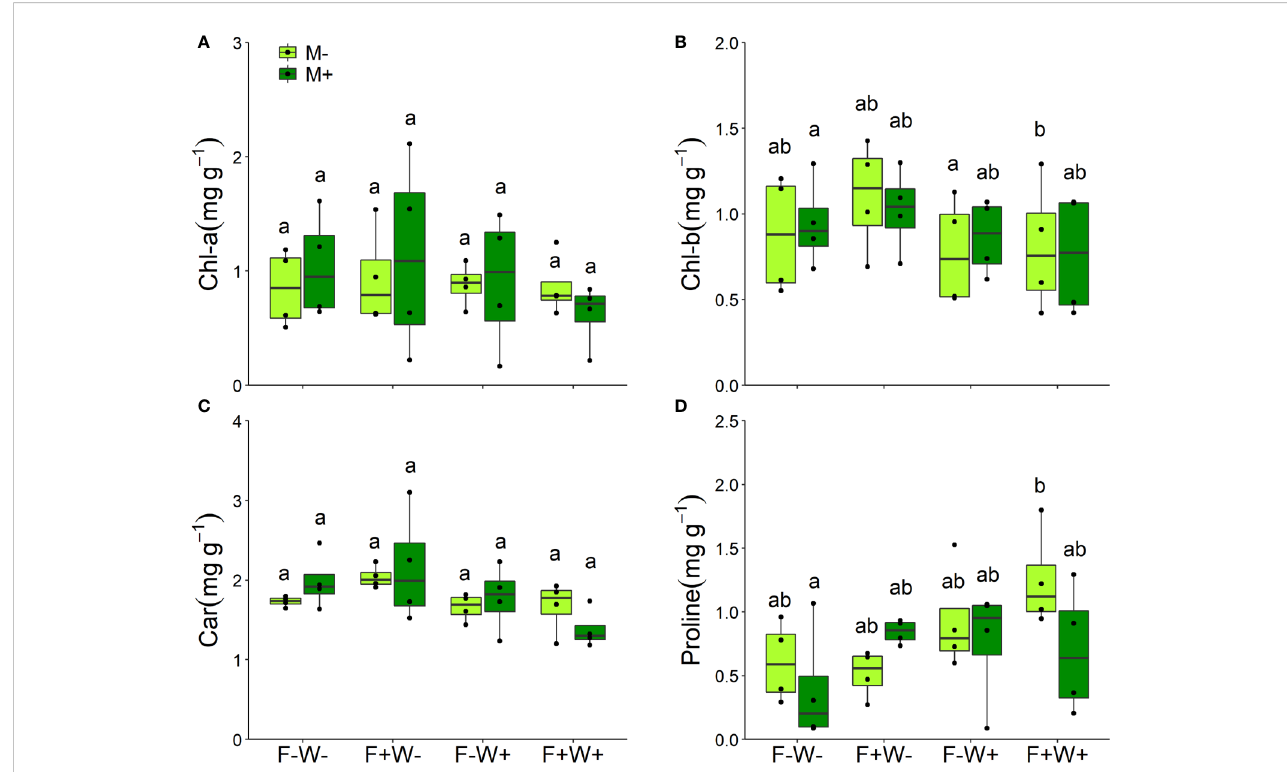
FIGURE 3 Contents of chlorophyll a (Chl-a, A ), chlorophyll b (Chl-b, B ), carotenoids (C) and proline (D) in the leaves of Artemisia ordosica plants that were inoculated with the AM fungal species Funneliformis mosseae (M+) or not (M-) and grown under four different combinations of fertilization (F-: no fertilization; F+: fertilization) and water addition (W-: low soil water; W+: high soil water) treatments. Light symbols: plants received no AMF; dark symbols: plants inoculated with AMF. The boxplot shows the 25% and 75% quartiles, the median, whiskers (1.5 times the interquartile range) and the outliers of the samples, and the points in the plot area represent different replicates of the corresponding treatment. Boxplots sharing one or more identical letters are not signi fi cantly different based on Tukey ’ s post hoc test. Statistics are shown in Table